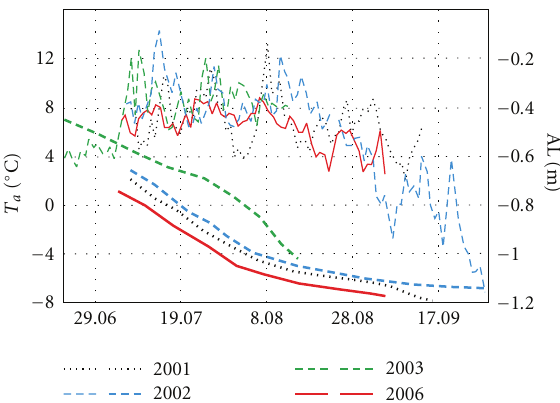
Figure 7: Seasonal thawing of permafrost near Skottehytta on the eastern coast of Petuniabukta, Central Spitsbergen (after [27] and own observations); Ta: air temperature (thin lines), AL: thawing depth (bold